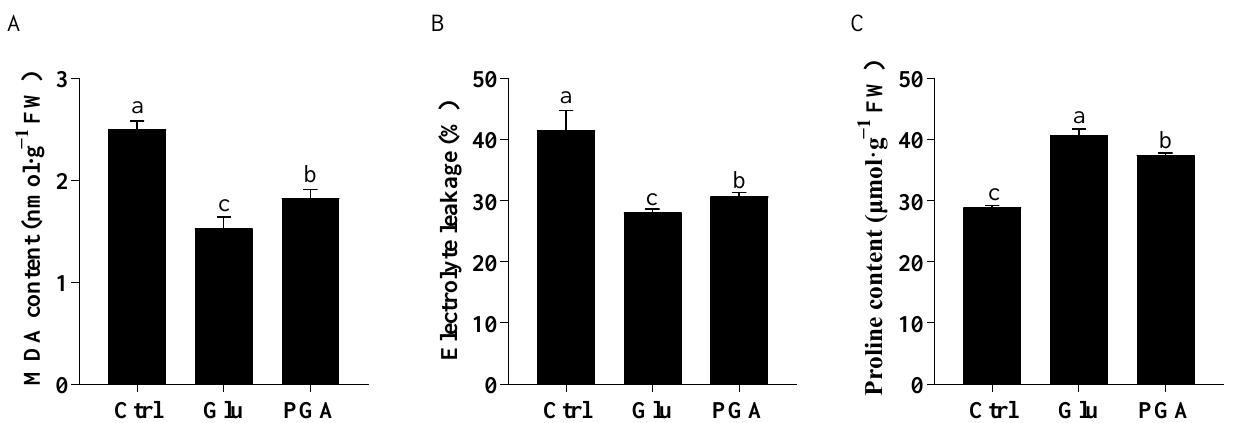
Figure 2. Effect of Glu and γ -PGA on MDA content ( A ), electrolyte leakage ( B ), proline content ( C ) in Chinese cabbage under heat stress. Data are shown as mean ± SD. Different lowercase letters indicate significant difference at p < 0.05.